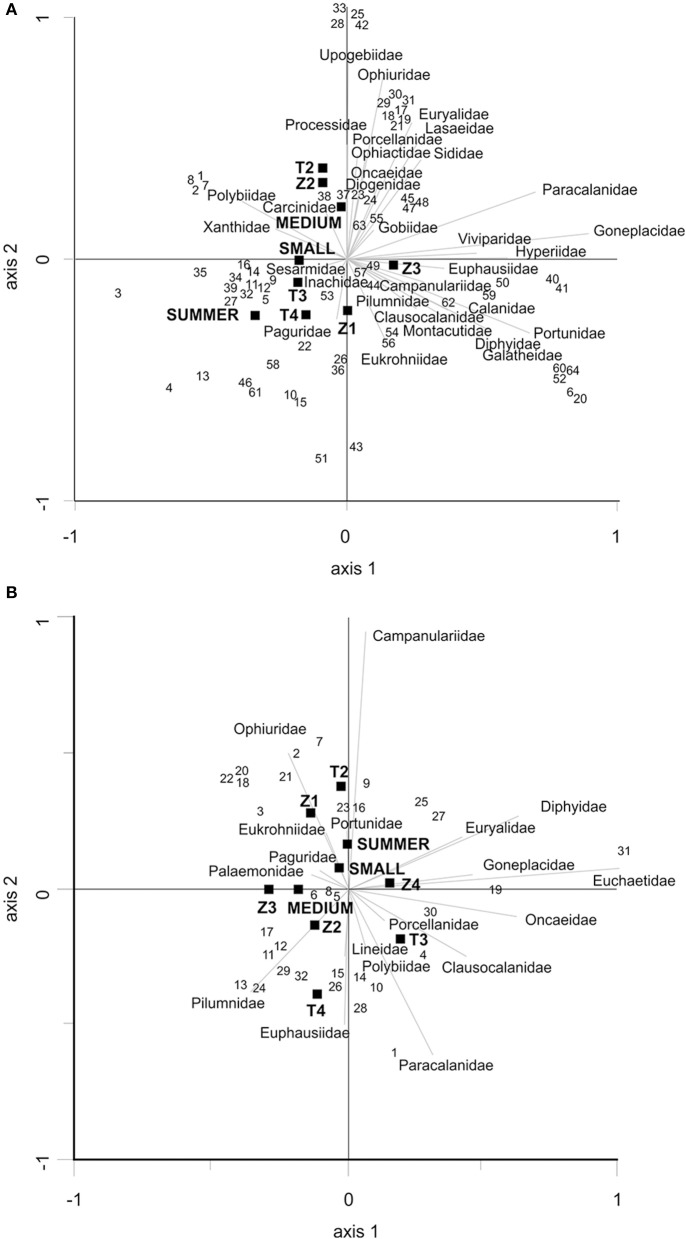
(A) RDA triplot for the O. vulgaris families identified with COI gene. The correlation matrix was used. The first axis explains 29.57% and the second axis explains 21.96% of the total sum of all canonical eigenvalues (0.192). All the explanatory variables were used. (B) RDA triplot for the A. media families identified with COI gene. The correlation matrix was used. The first axis explains 27.26% and the second axis explains 21.47% of the total sum of all canonical eigenvalues (0.39). All the explanatory variables were used.